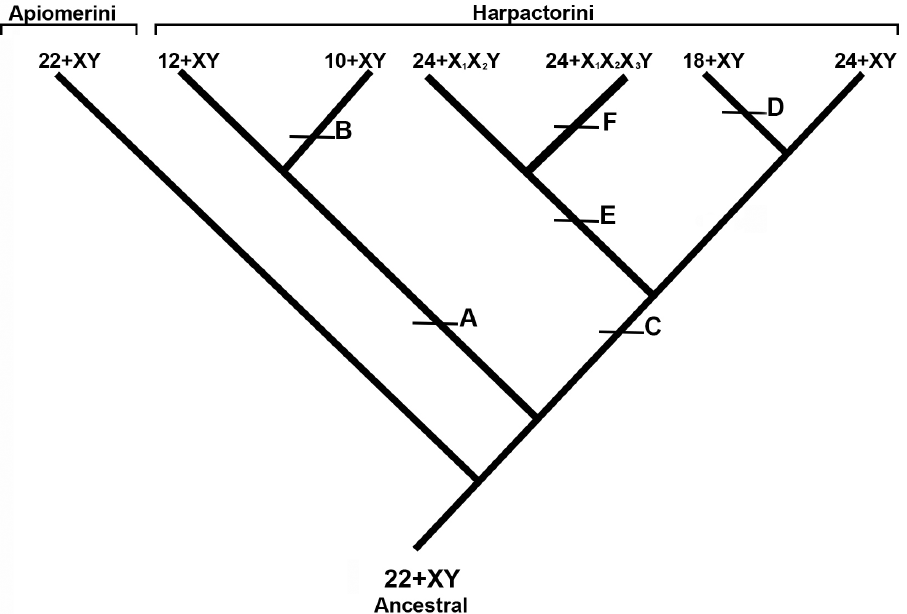
Figure 2. Chromosomal evolution in Apiomerini and Harpactorini. Evolutionary events marked by caps: A fusion of autosomes B fusion of autosomes C fission of autosomes D fusion of autosomes E fis- sion of sex chromosomes F fission of sex chromosomes. Chromosomal formulae represent the diploid number. The tribe Dicrotelini was not included in scheme because only one species has been studied cytogenetically in this